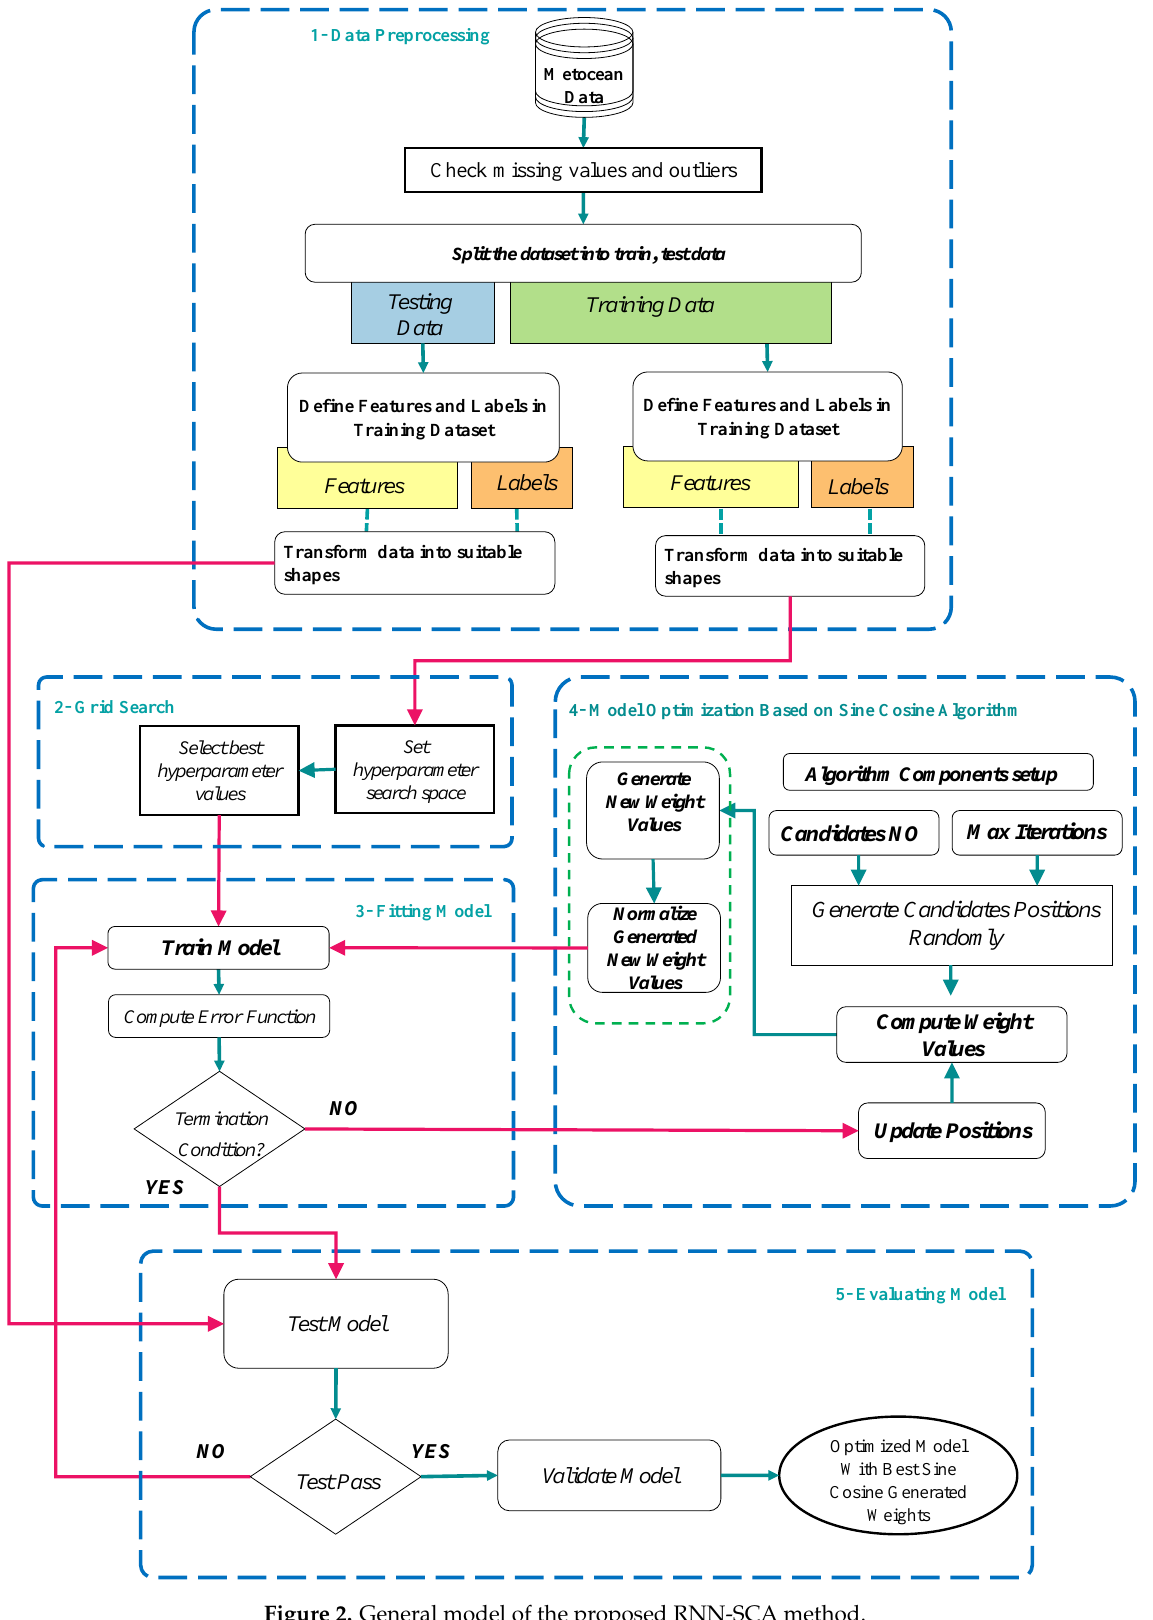
Figure 2. General model of the proposed RNN-SCA